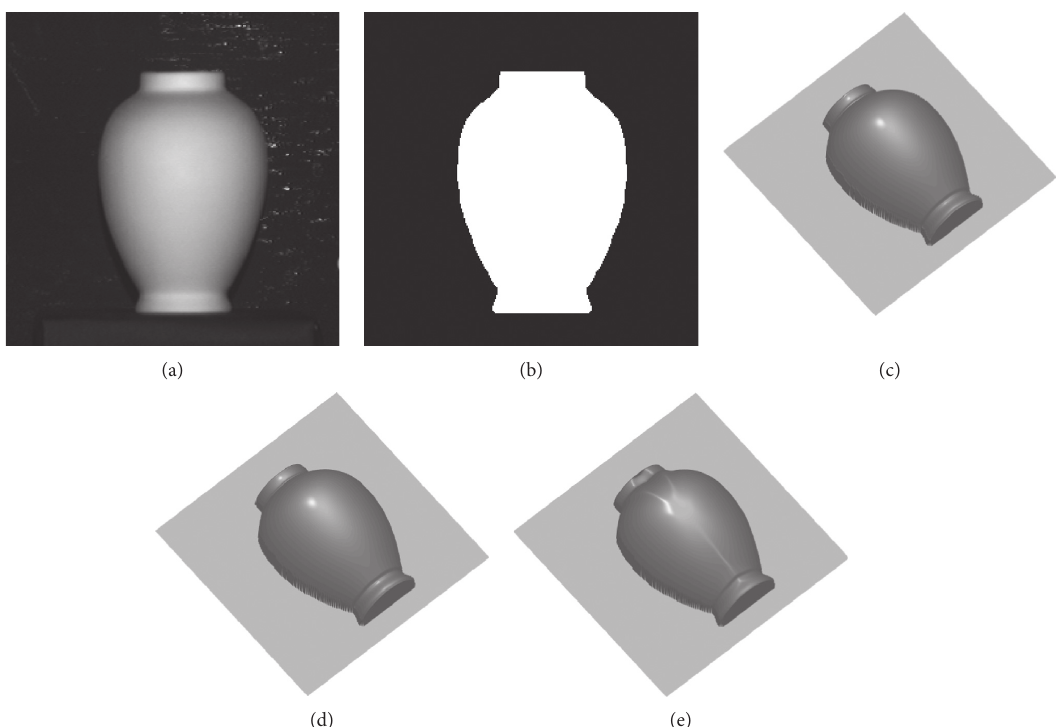
Figure 5: Experimental results for the real vase image. (a) The real image. (b) The mask of (a). (c) Reconstructed surface of (a) using first- order Godunov-based scheme. (d) Reconstructed surface of (a) using high-order Godunov-based scheme. (e) Reconstructed surface of (a) using Lax–Friedrichs sweeping